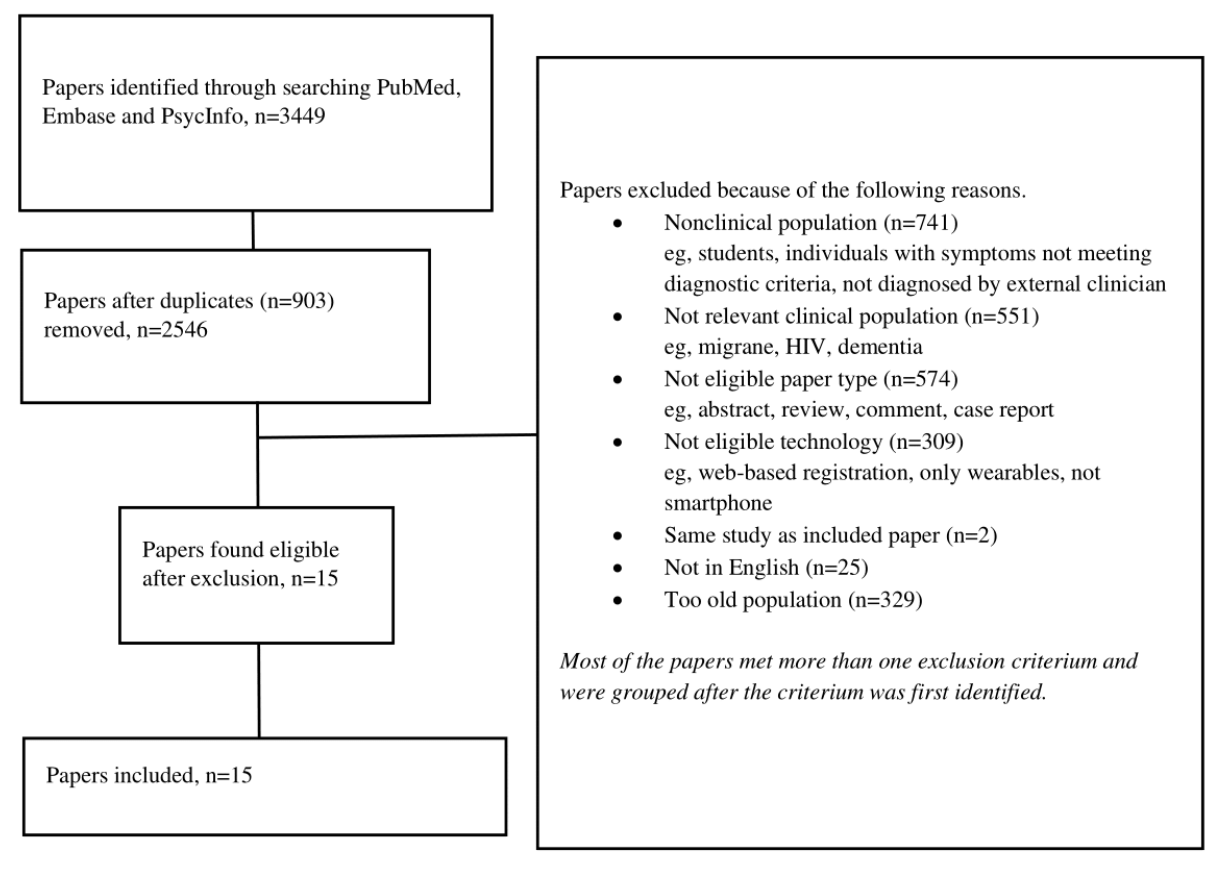
Figure 1. PRISMA (Preferred Reporting Items for Systematic Reviews and Meta-Analysis) flow diagram displaying information on study flow from initial search to final